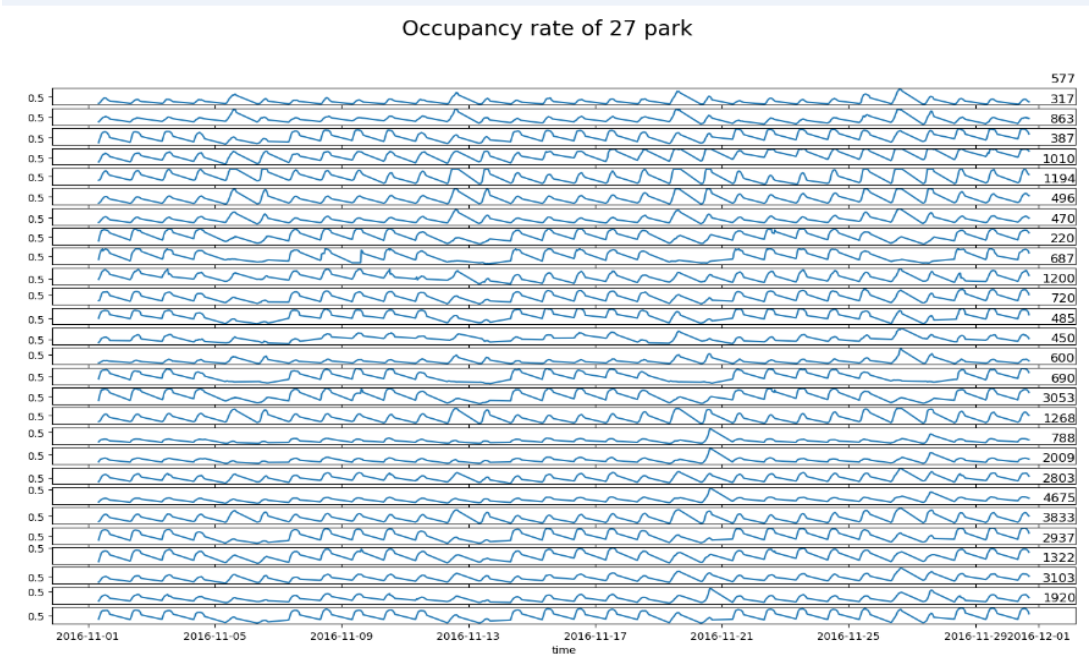
Figure 1. The occupancy rate of 27 car parks in Nov., 2016.